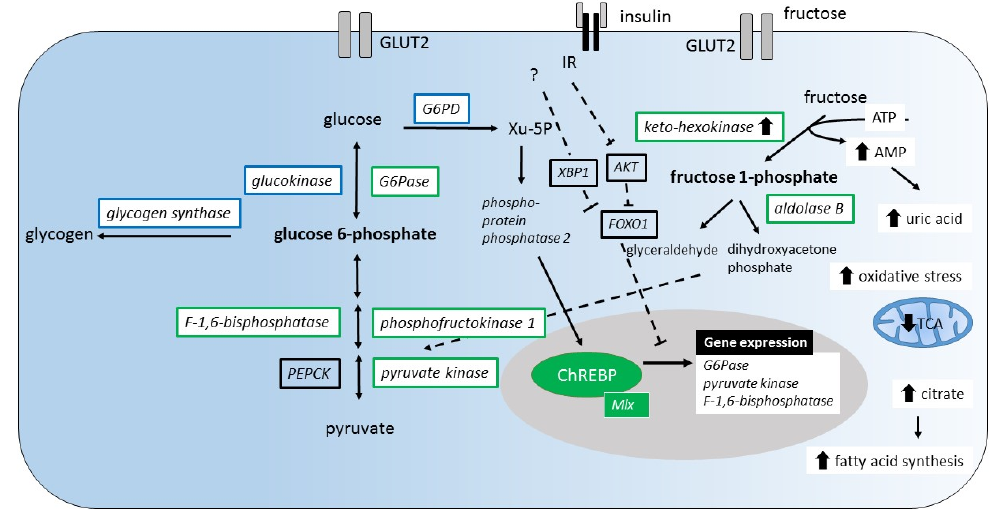
Figure 3. Changes of hepatic gene expression and metabolic pathways induced by fructose. (A) Fructose stimulates the expression of the fructose metabolizing enzymes (keto-hexokinase and aldolase B), glycolytic enzymes (phosphofructokinase 1, pyruvate kinase), but also the expression of gluconeogenic enzymes (glucose 6-phosphatase (G6Pase), F-1,6-bisphosphatase, pyruvate kinase (green)). These effects are thought to be mediated by transcription factor carbohydrate responsive element binding protein (ChREBP). Fructose is suggested to increase xylulose-5 phosphate (Xu-5P) levels, which leads to nuclear translocation of ChREBP. It is suggested that fructose induced ChREBP activation dominates over the insulin and/or X-Box Binding Protein 1 (XBP-1) suppressive effects mediated by forkhead box O1 (FOXO1) inhibition. (B) Increasing levels of uric acid from adenosine mono-phosphate (AMP) catabolism increase mitochondrial oxidative stress. The resulting inhibition of tricarboxylic acid cycle (TCA) increases the mitochondrial citrate release stimulating fatty acid synthesis. IR, insulin receptor; G6PD, glucose 6-phosphate dehydrogenase; PEPCK, phosphoenolpyruvate carboxykinase; ATP, adenosine